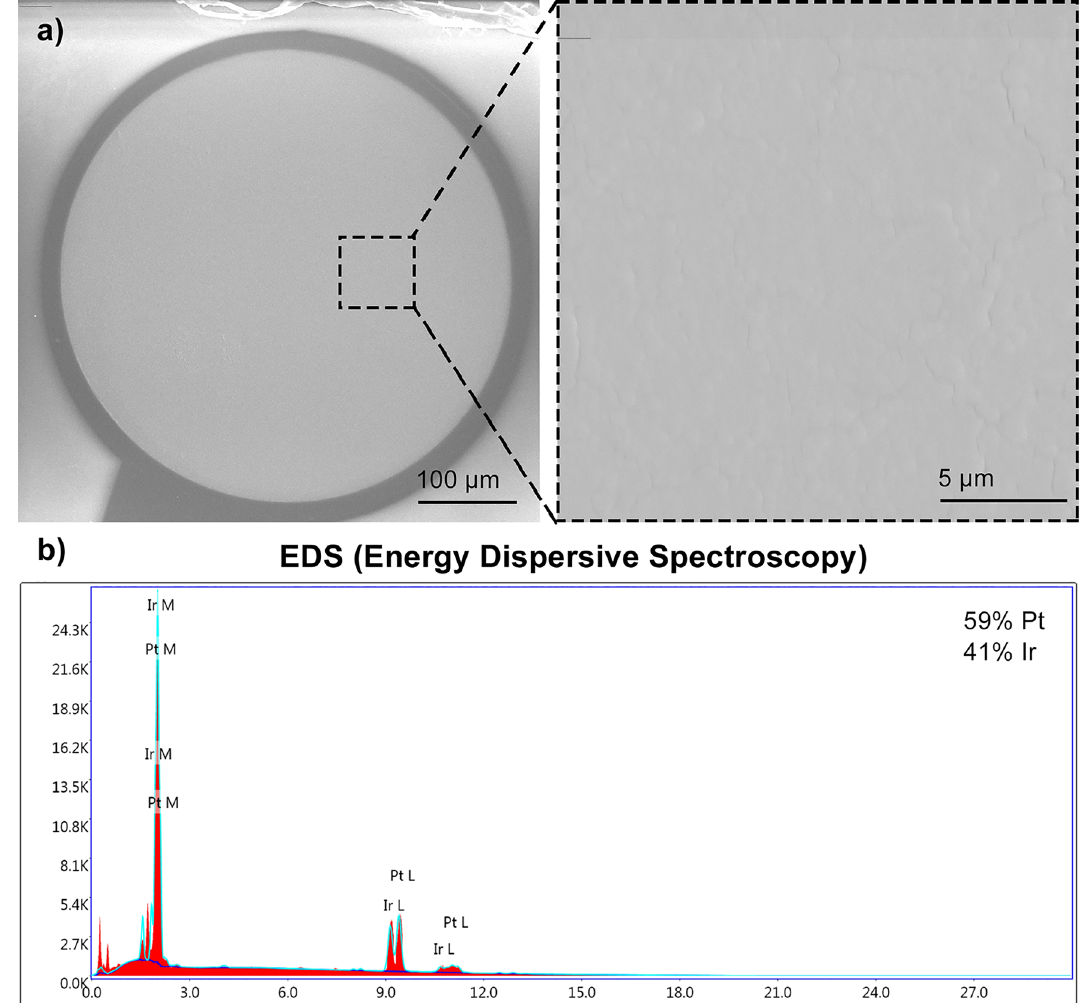
Figure 5. SEM image and EDS characterization of one representative electrode. ( a ) SEM image of one electrode shows the insulation of polyimide and the Pt/Ir alloy coating on the electrode surface. ( b ) Chemical spectra from the EDS map on the electrode active surface indicates two different peaks associated to Pt and Ir both at 9 keV and 11 keV. EDS map is generated using The EDAX TEAM EDS software suite. URL to the software: https:// www. edax. com/-/ media/ amete kedax/ files/ eds/ produ ct_ bulle tins/ team% 20eds% 20soft ware% 20sui te.